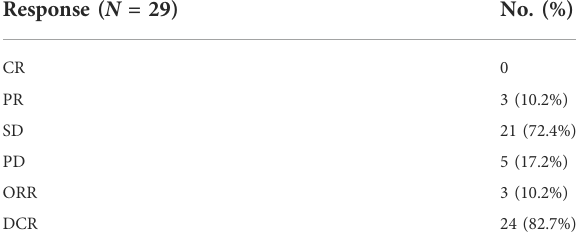
TABLE 2 Con fi rmed best overall responses.